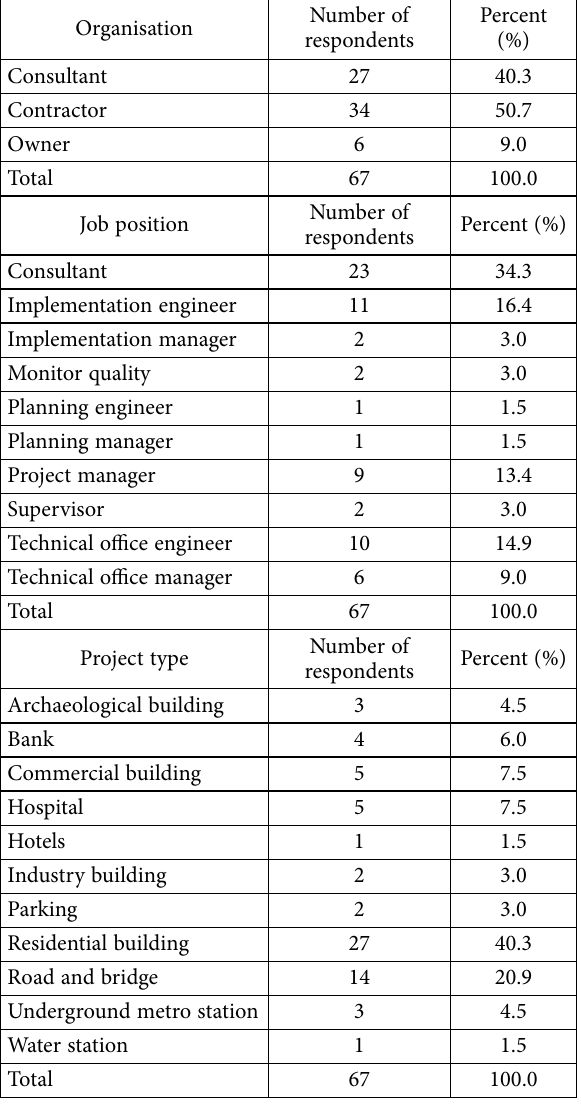
Table 3. Respondents’ statistics